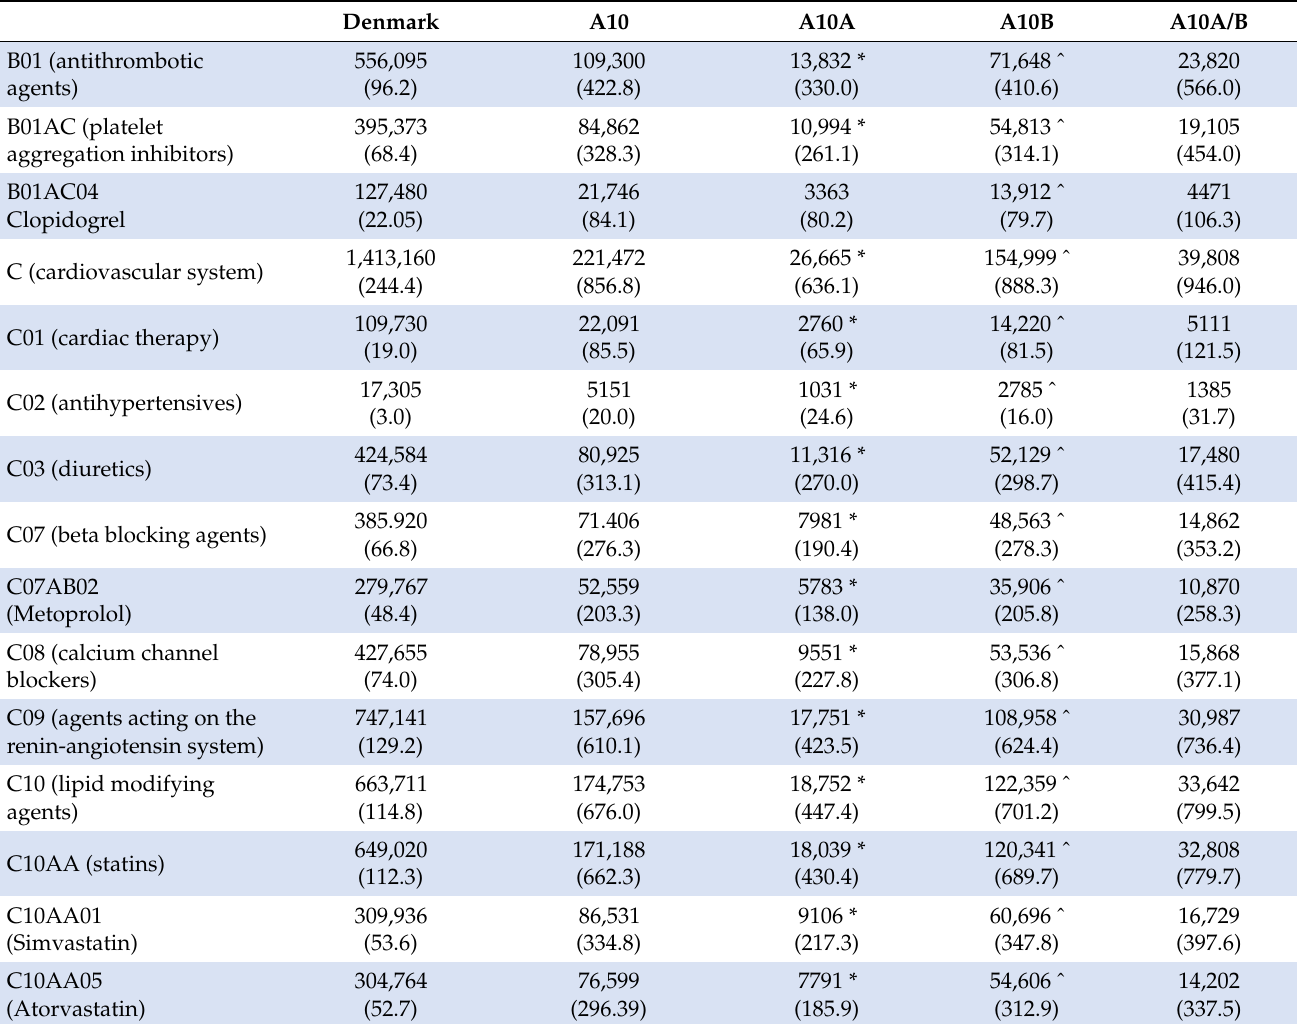
Table 2. Number of users and prevalence of platelet aggregation inhibitors and cardiovascular drugs. Denmark